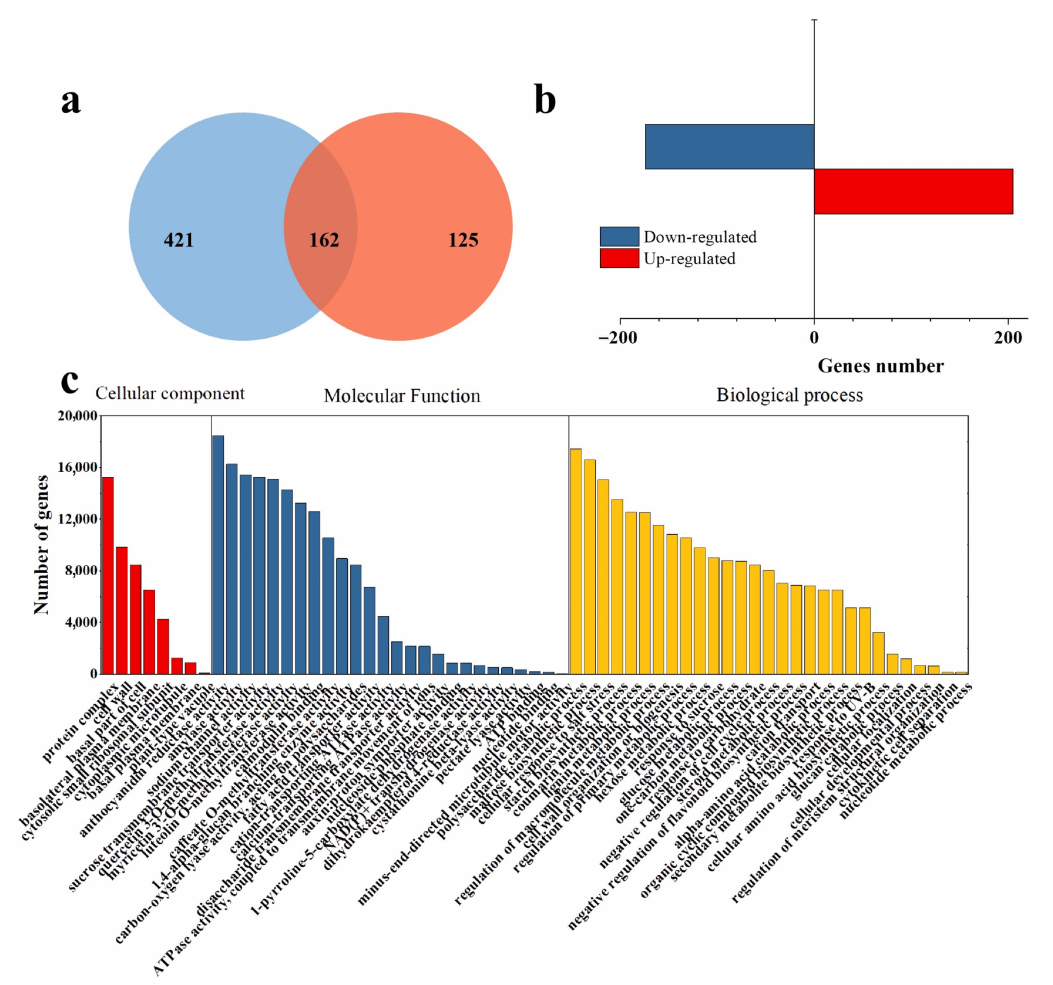
Figure 1. The transcriptome analysis result. ( a ) Venn diagram of DEGs; ( b ) The up- and down- regulated gene numbers in DEGs; ( c ) GO functional classification of DEGs between low salinity and high